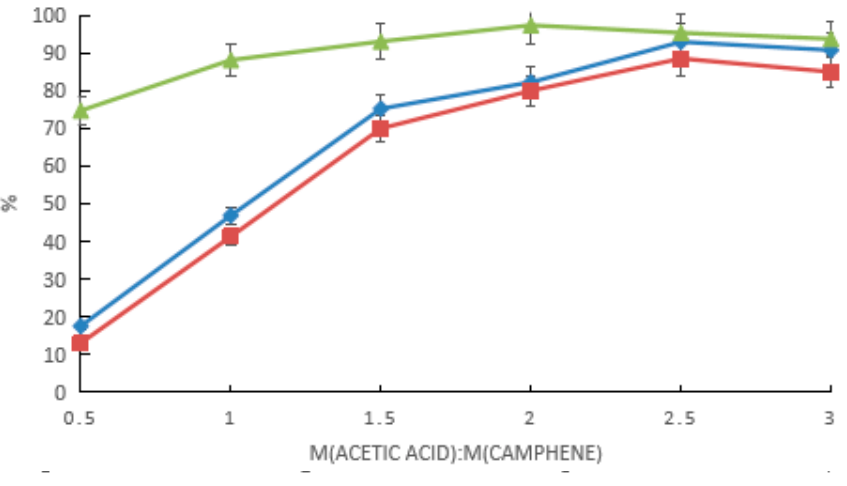
Figure 3. Effects of the acetic acid dosage on the camphene esterification reaction. Reaction conditions: m(camphene):m(tartaric acid):m(boric acid) = 10:0.5:0.4, reaction temperature of 70 ◦ C, and reaction time of 18